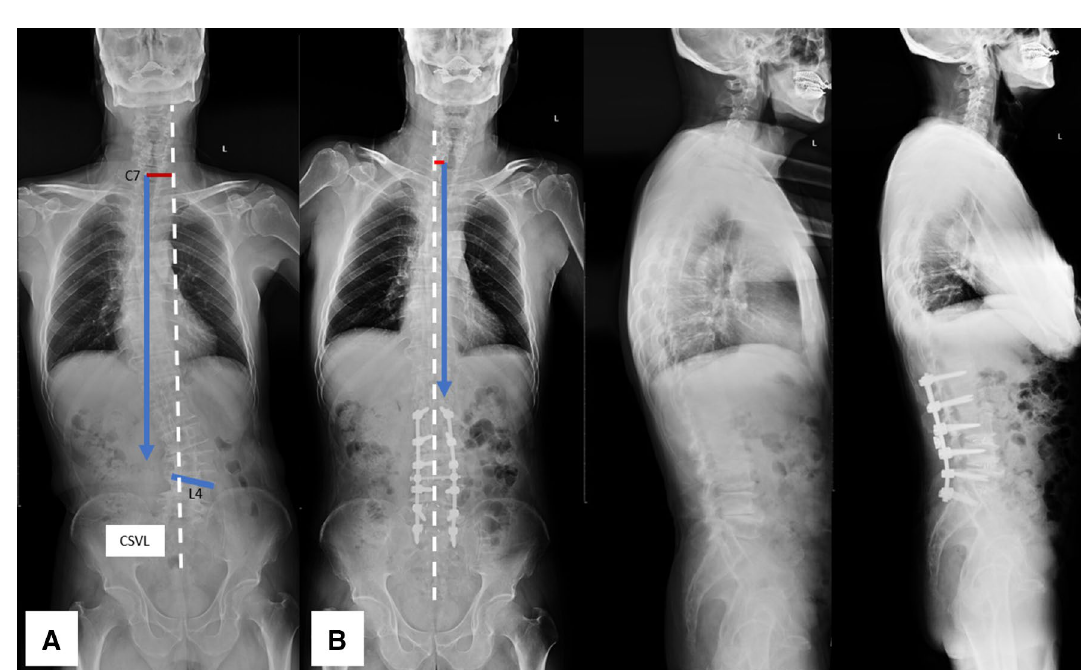
Figure 2. Coronal opposition pattern ( A ). A 71-year-old male with coronal opposition pattern obtained satisfactory correction of coronal imbalance after surgery ( B ). GCM changed from 42.0 mm preoperatively ( A ) to 13.8 mm postoperatively ( B ), with C7 plumb line moved from right side to left side of CSVL. CSVL central sacral vertical line, GCM : global coronal